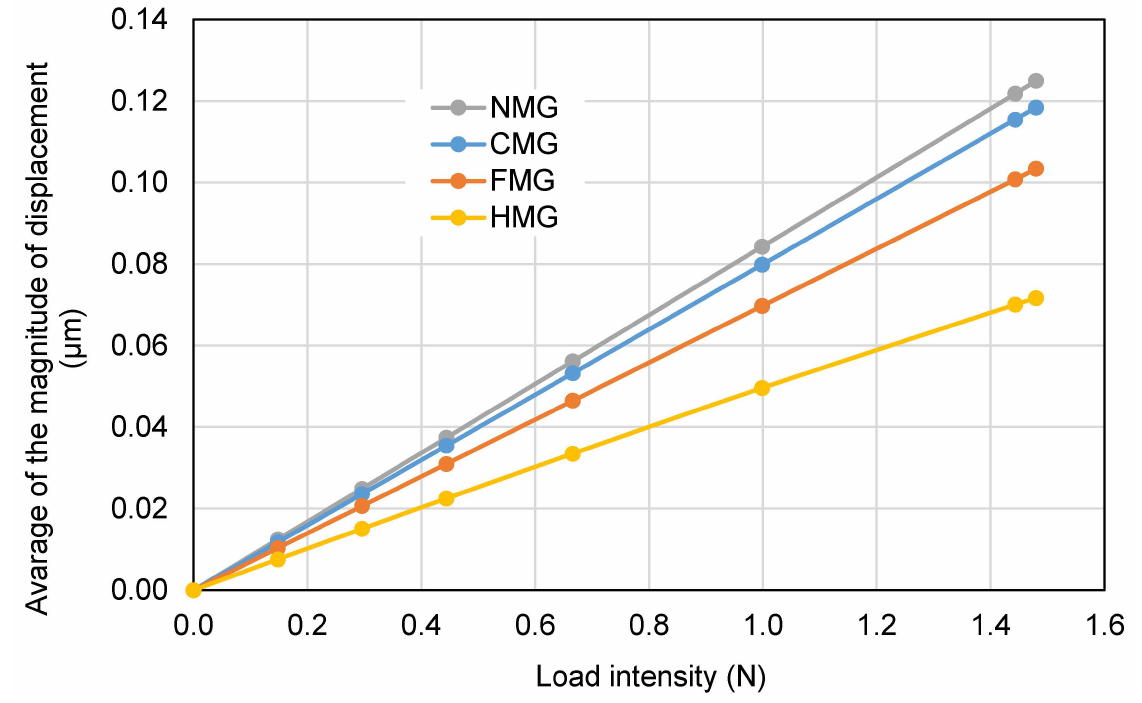
Figure 6. Numerical variation of the average magnitude of displacement with the load intensity. Table 6 shows the average and the range values of displacements in the maxilla and in the soft tissue. Again, the results show that the HMG model is the one that stands out for presenting lower values of the magnitude of displacement in the maxilla bone and higher values in the soft tissue. Figure 7 shows the main differences among the distributions of the displacement magnitude in the soft tissue of all models. Table 6. Mean and range of displacements over the maxilla bone and the soft tissue.